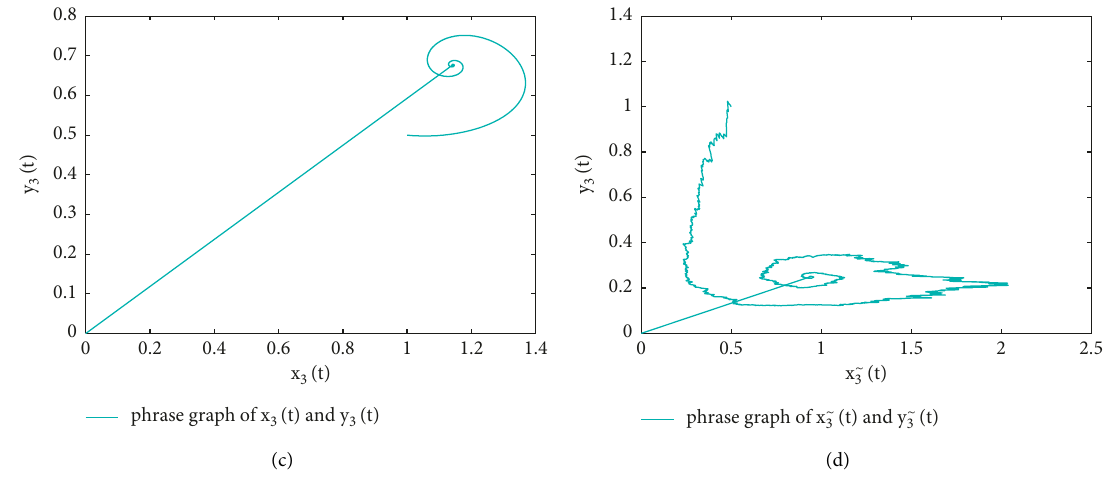
� 0 ,f � 1 1 2 ( t ) and y ∼ ( t )( i � 1 , 2 , 3 ) i i � 2. (d) The phase graph of 3